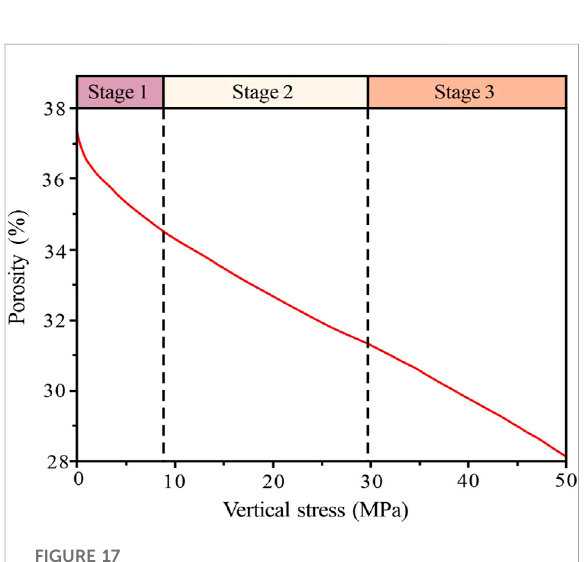
FIGURE 17 Porosity evolution characteristics of coarse sand.